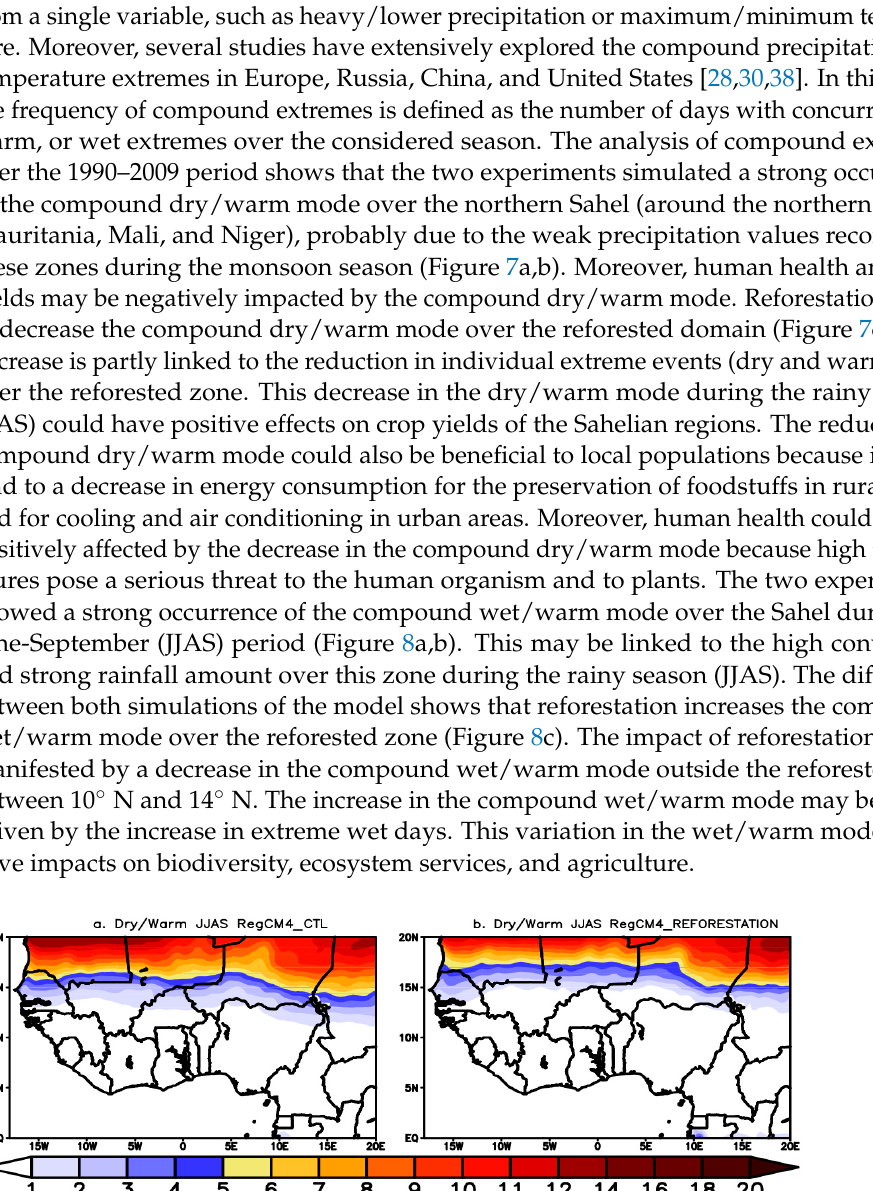
Figure 8. Number (expressed in days) of compound wet/warm during the JJAS period averaged from 1990 to 2009 over West Africa for: ( a ) RegCM4_CTL; ( b ) RegCM4_REFORESTATION and ( c ) RegCM4_REFORESTATION—RegCM4_CTL.